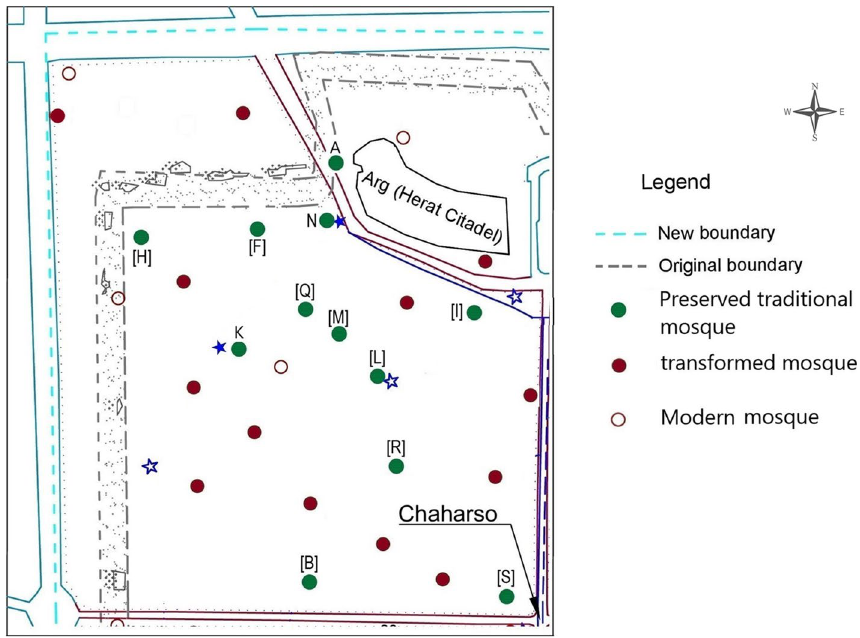
Fig. 2 Distribution of mosques, 2021 (Source: the